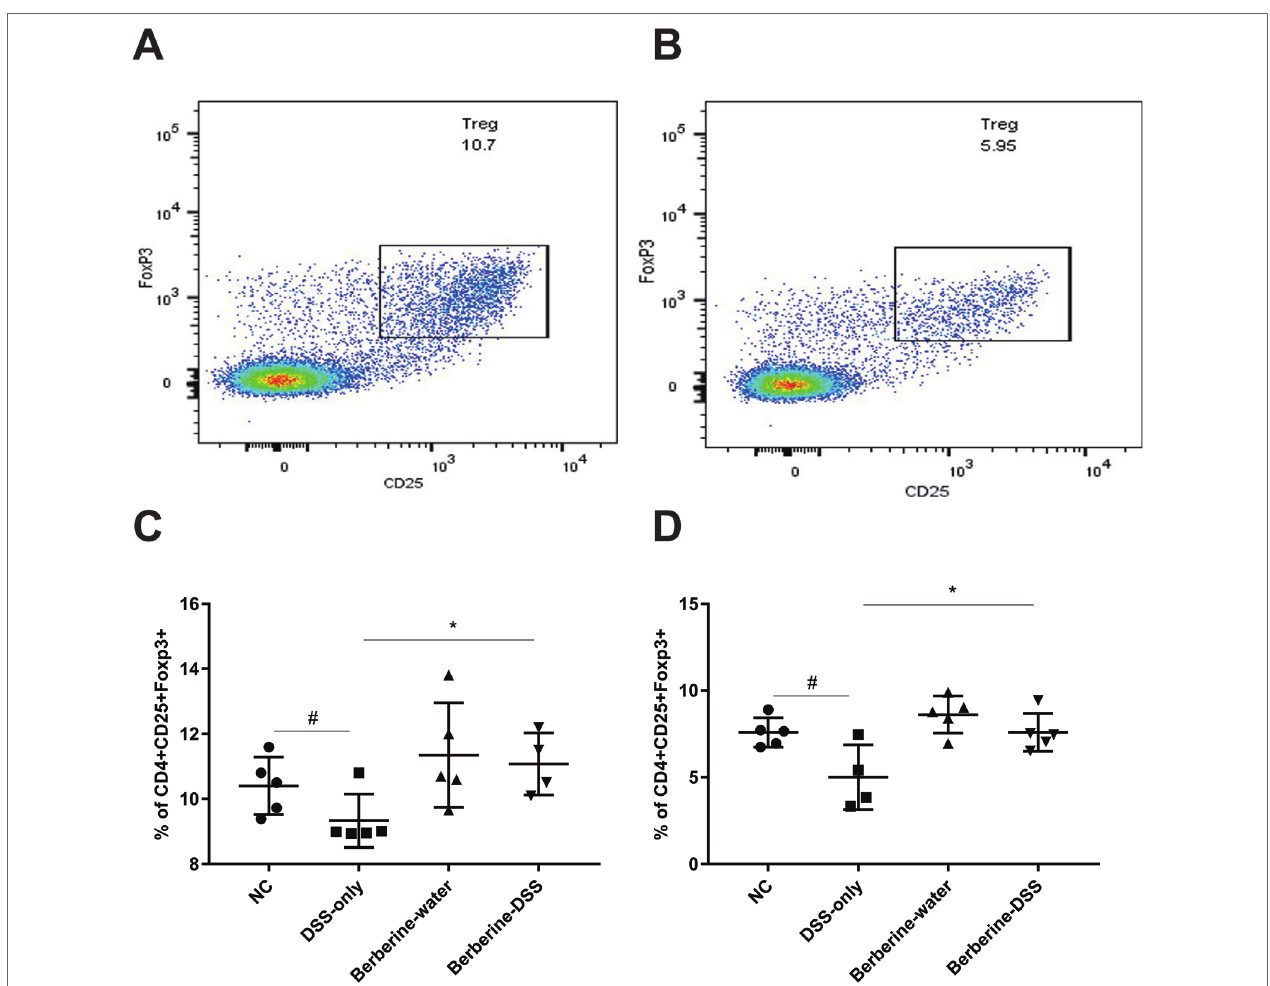
FIGURE 3 | Effects of berberine on the differentiation. The proportion of regulatory T cells in mesenteric lymph nodes (MLNs) and spleens was evaluated by flow cytometry. (A and C) Tregs in MLNs ( n = 7). (B and D) Tregs in spleens ( n = 7). * P < 0.05, # P <